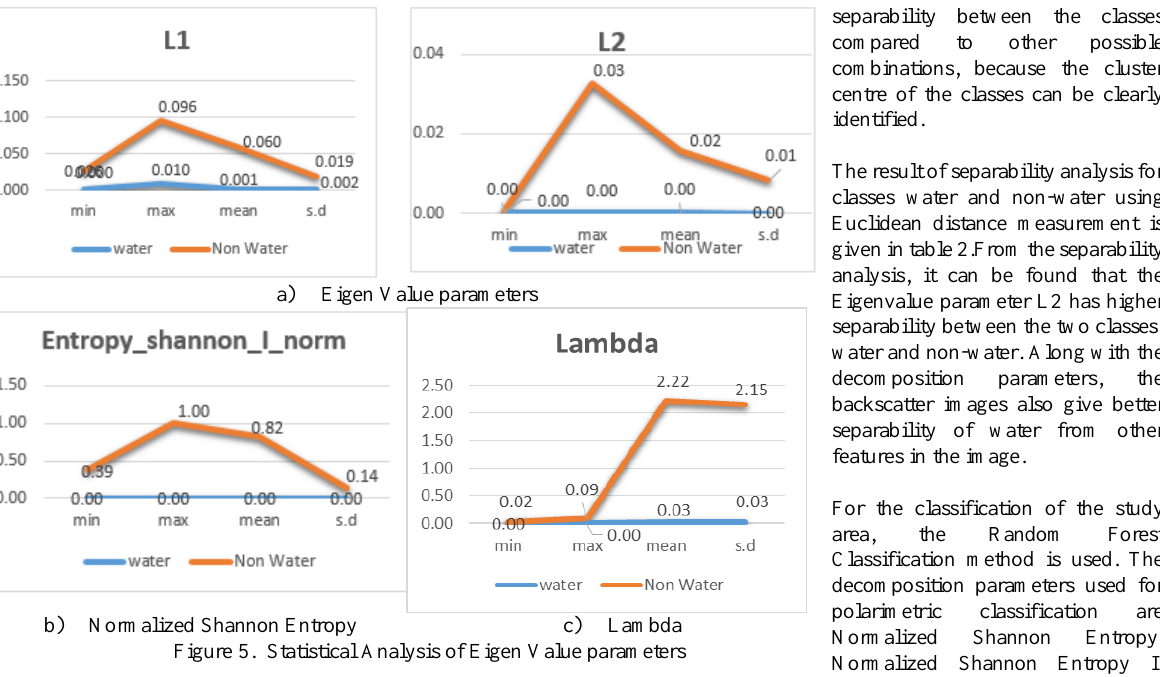
Figure 5. Statistical Analysis of Eigen Value parameters From the figure 6 showing the feature spaces obtained through Euclidian distance separability analysis, it can be seen that the band combination of Normalized Shannon entropy with L1, L2 & Lambda, combination of Normalized Shannon entropy I with L2 and combination of L2 with L1 & Lambda gives maximum